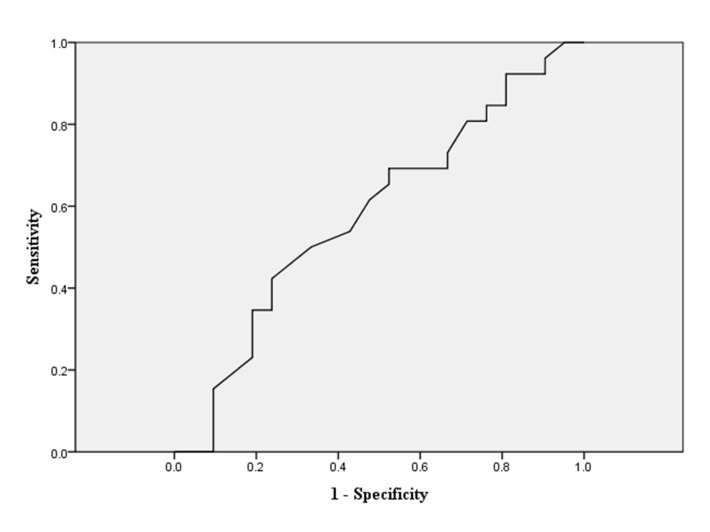
The ROC curve for the OSTA index predicting good neurologic recovery in the younger group (age<40).ROC curve of OSTA index with respect to detecting younger patient with GOS 5 with an AUC of 0.582.